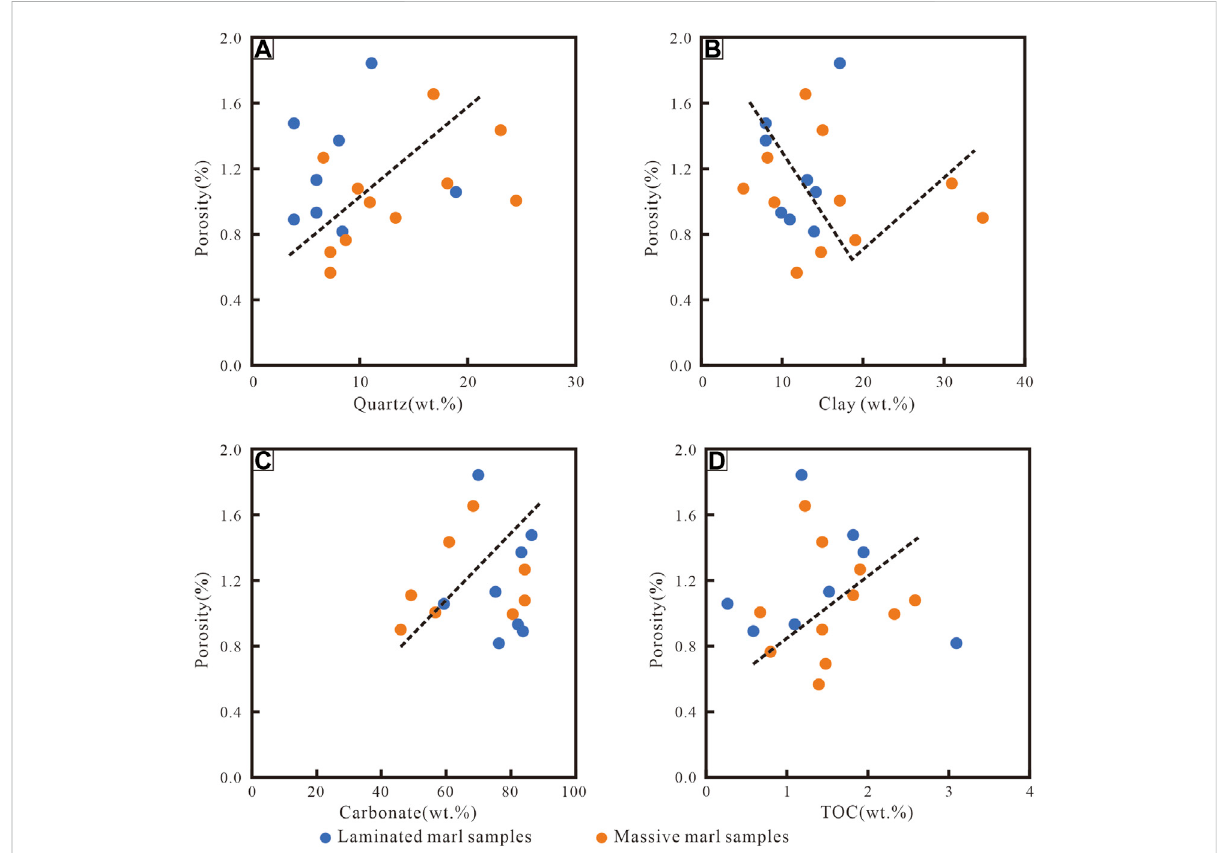
FIGURE 11 Relationships between the material composition and porosity of the marl samples from the ST1, Shulu Sag: (A) , relationship between quartz content and total porosity; (B) , relationship between clay content and total porosity; (C) , relationship between carbonate content and total porosity; (D) , relationship between TOC content and total